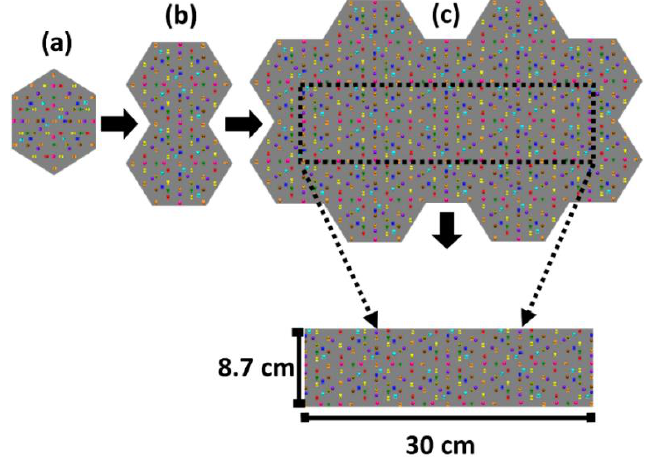
Figure 3. ( a ) The base hexagon unit cell. ( b ) Combined two-unit cell. ( c ) Extraction of a 30 cm × 8.7 cm rectangular printed circuit board from a 12-unit cell array.